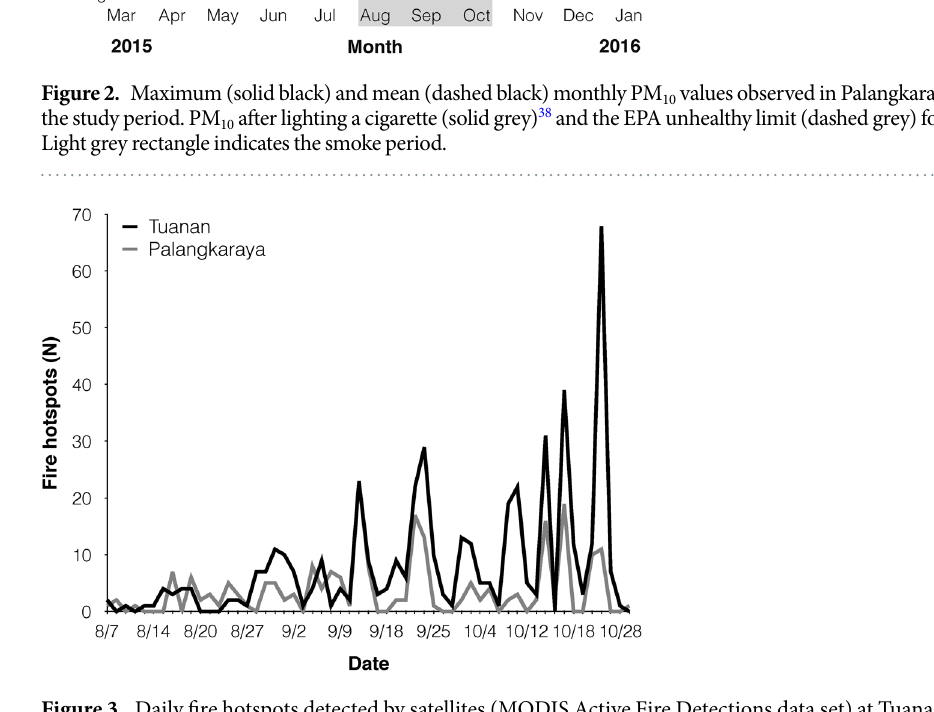
Figure 3. Daily fire hotspots detected by satellites (MODIS Active Fire Detections data set) at Tuanan (black) and Palangkaraya (grey) during the fire season.